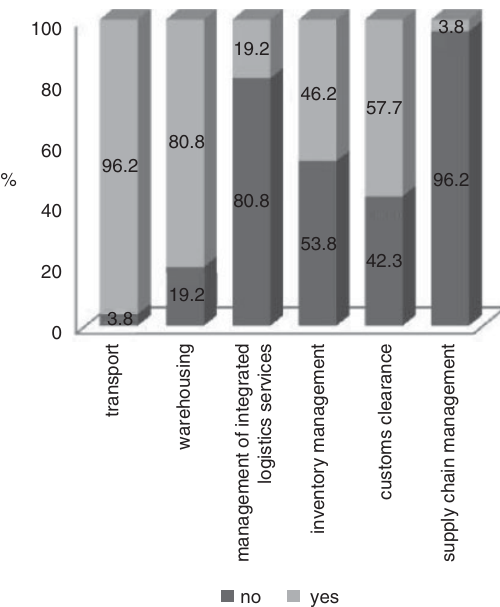
Fig. 4. Level of demand for